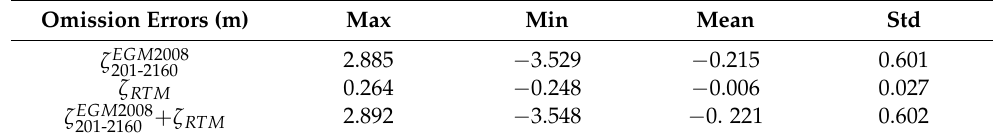
Table 2. Statistics of the omission errors for satellite-only GFMs in China. Unit: m.